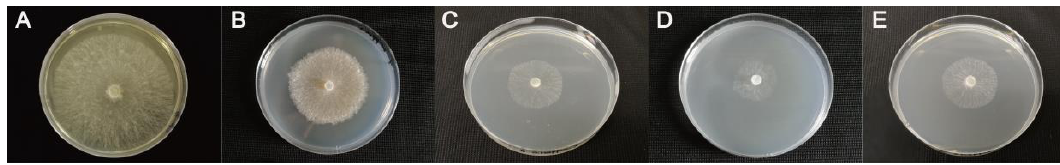
Figure 7. Colony growth of Rhizoctonia solani under treatment with different pesticide preparations ( A ) blank control; ( B ) VWP; ( C ) TSC; ( D ) dual-functionalized pesticide nanocapsules; and ( E ) VTSC. Table 2. Bioactivity of the dual-functionalized pesticide nanocapsules against Rhizoctonia solani. Treatments